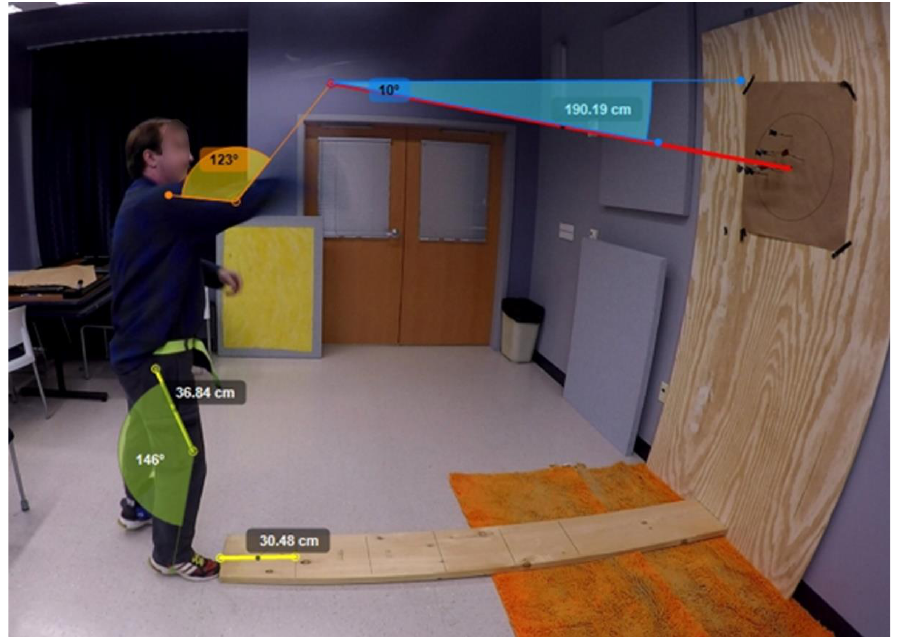
Figure 4. Illustration of the utilized video